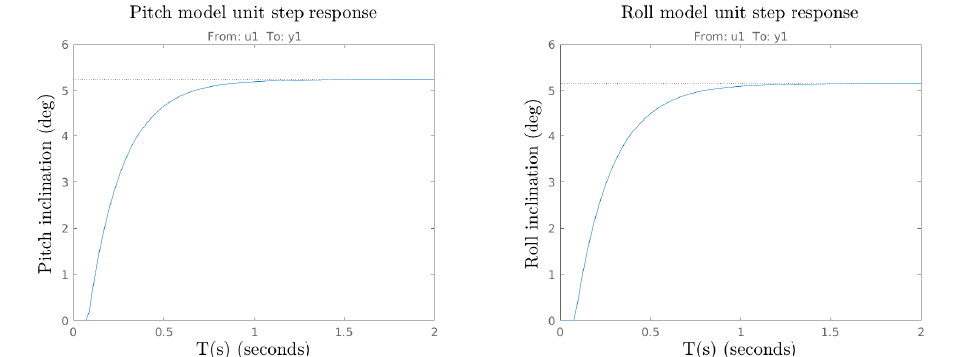
Figure 6. Unit input time response for G θ ( s ) ( left ) and G φ ( s ) ( right